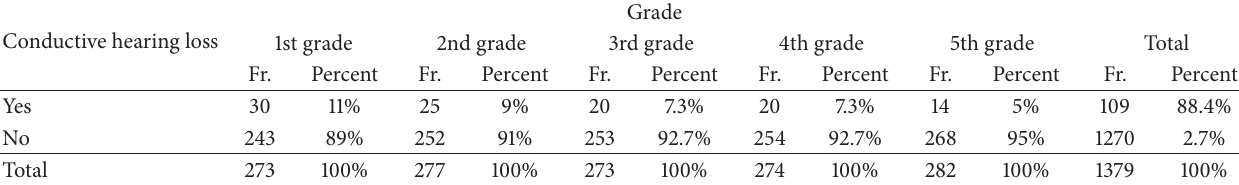
Table 3: Frequency distribution of conductive hearing loss based on grade.